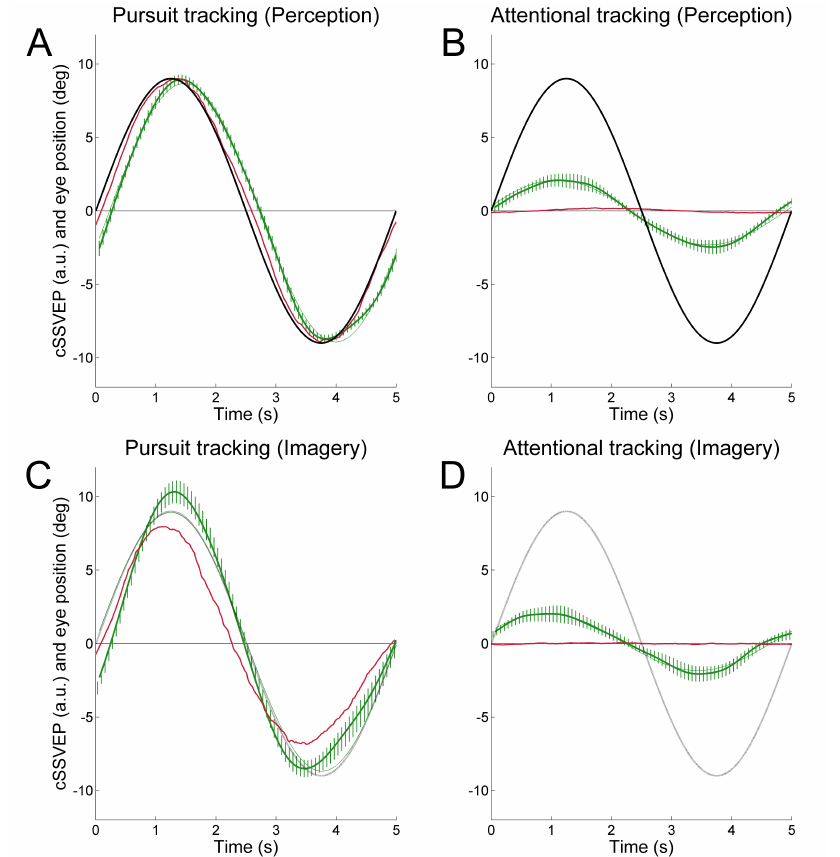
Figure 1: Average cSSVEP modulation (dark green traces) during horizontal sinusoidal tracking in Pursuit (A, C) and Attentional (B, D) tracking. Only the second (perception: A, B) and third (imagery: C, D) tracking cycles are shown. The thickness of the vertical lines represents the instantaneous 99% confidence interval around the mean. The thin dark sinusoidal curves superimposed on the cSSVEP traces are the best fitting curves. Target position and average eye position are illustrated in black and dark